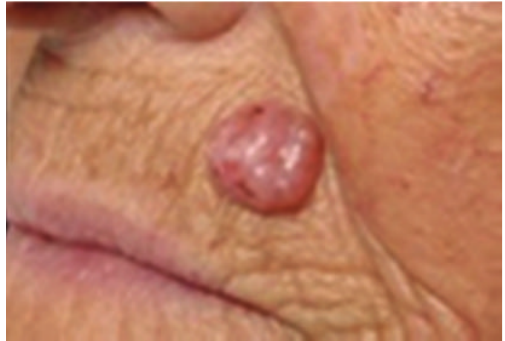
Figure 1: Nodulo-cystic BCC.